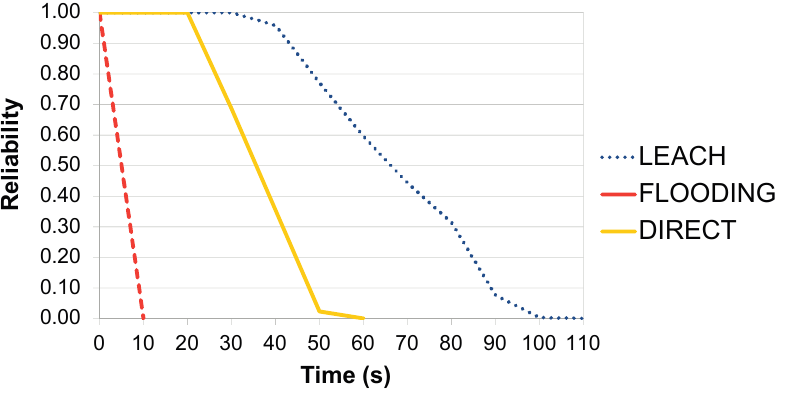
Figure 18. Reliability of a region using three different routing